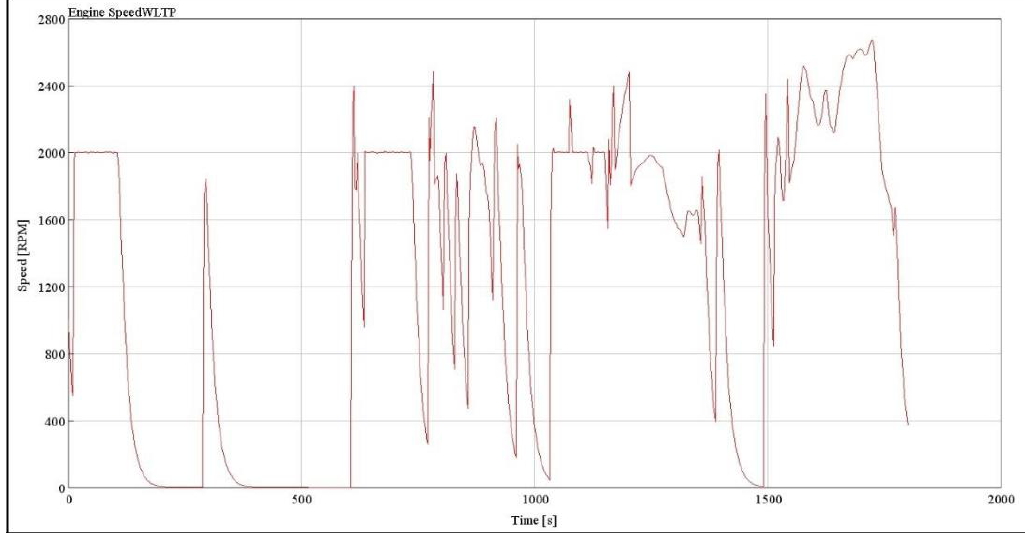
Figure 31. Engine speed (WLTP).